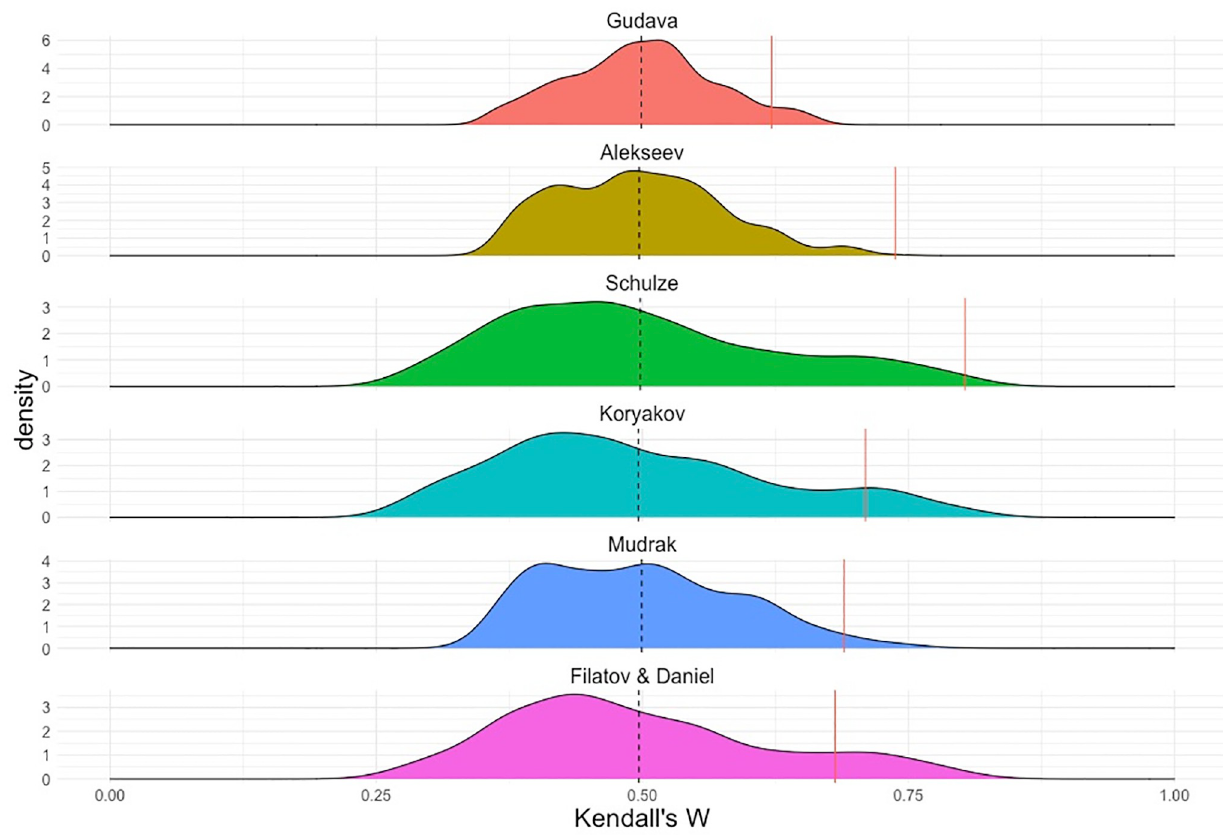
Fig 7. Distributions of Kendall’s W for permuted phylogenies (1,000 permutations). Dashed lines represent the mean of the distribution (W = 0.5 in all cases), andfull red lines represent the observed value for the phylogeny, as red bars in Fig 6.